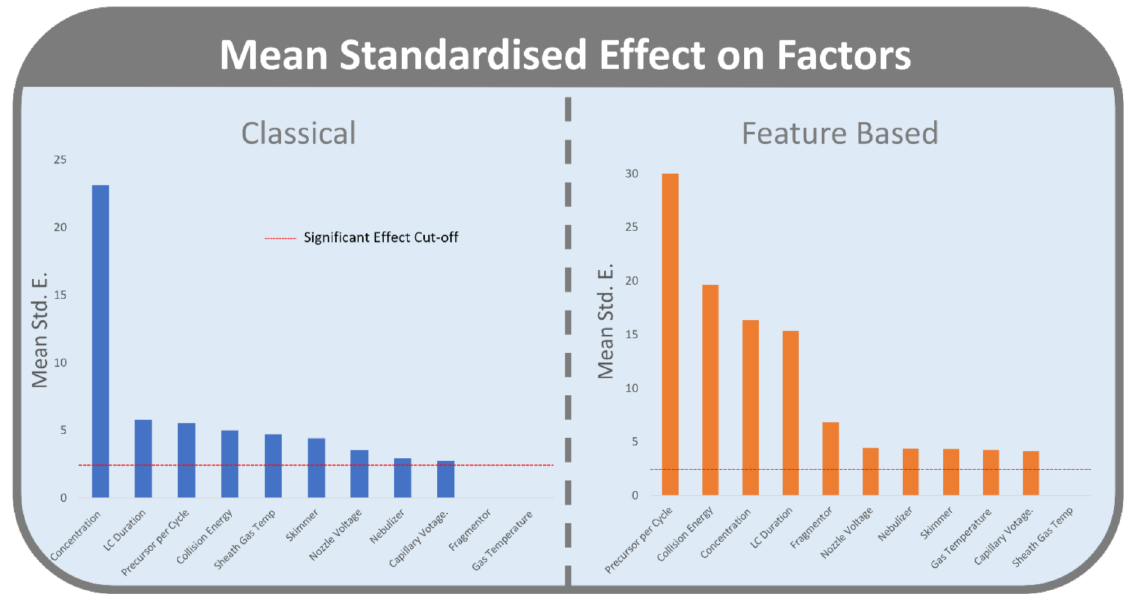
Figure 3. Significant effects of factors on CLMN (blue, left ) and FBMN (orange, right ), averaged across response models and samples. For included models, refer to Figure S11. Standardized Effects (Std E) of 2.27 or greater is considered significant (red dashed